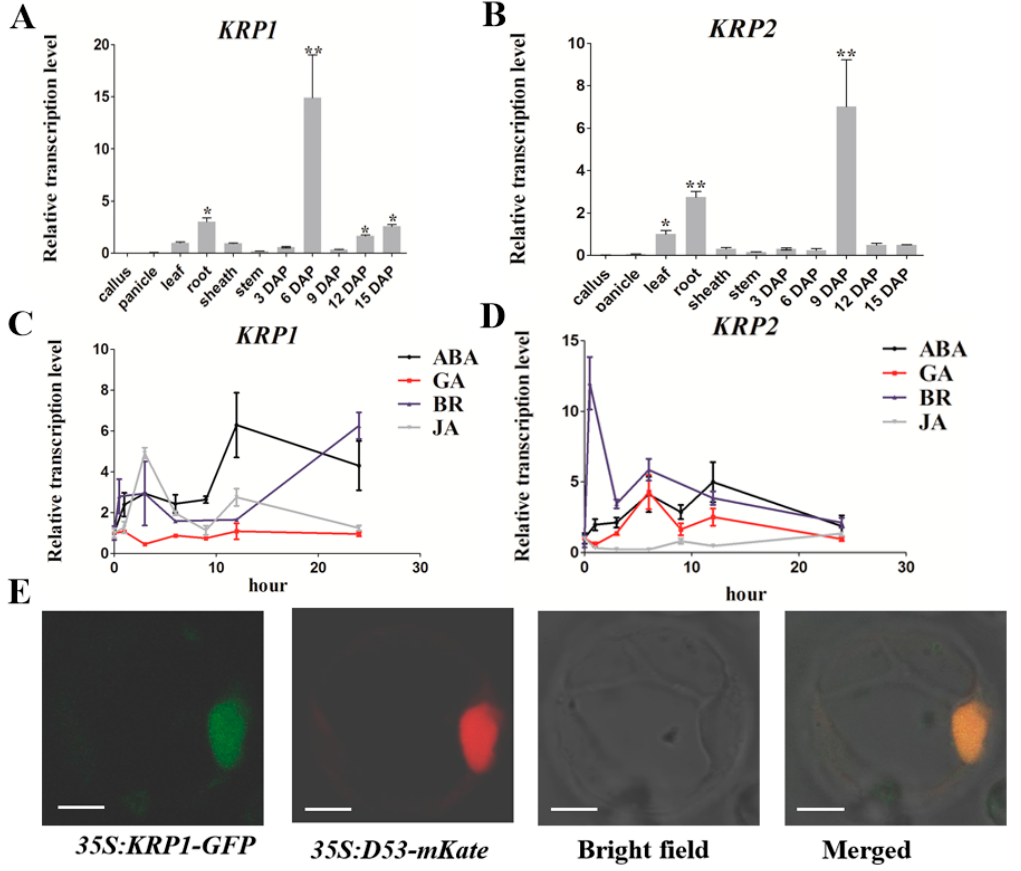
Figure 1. Expression pattern of KRP1 and KRP2 . ( A , B ) qRT-PCR analysis of KRP1 and KRP2 transcription abundances in various rice tissues, respectively. Asterisks indicate the significant difference of other tissues compared with callus, as determined by Student’s t -test analysis: * p < 0.05. ** p < 0.01; ( C , D ) qRT-PCR analysis of KRP1 and KRP2 transcription abundances in response to various phytohormone treatments, respectively. ABA: abscisic acid; GA: gibberellic acid; BR: brassinosteroids; JA: Jasmonic acid; ( E ) subcellular localization of KRP1–GFP fusion protein in rice protoplasts. D53 fused with mKate was used as a nuclear marker as described [20]. Bar = 10 µM. Error bars indicated SD with biological triplicates ( n = 3) in ( A – D ). Primers used for qRT-PCR analysis were listed in Table S1.